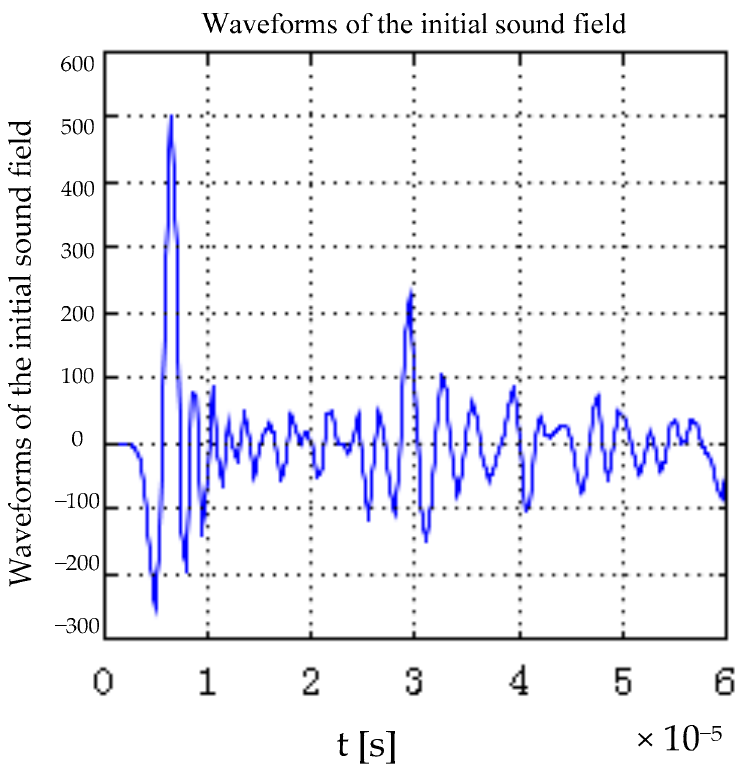
Figure 9. Waveform of the initial sound field .